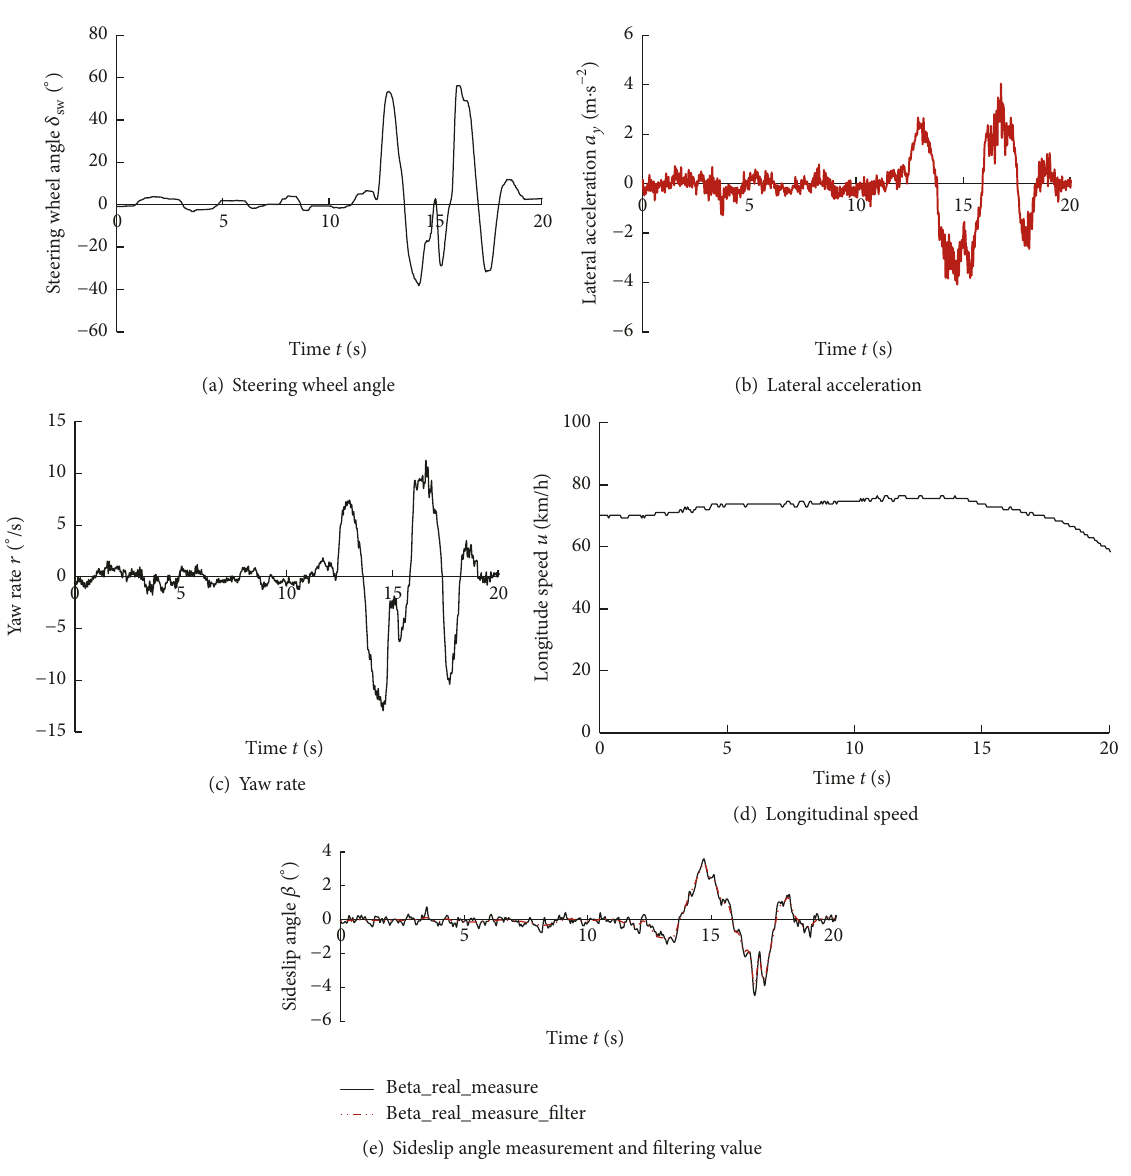
Figure 10: Vehicle state parameters under line